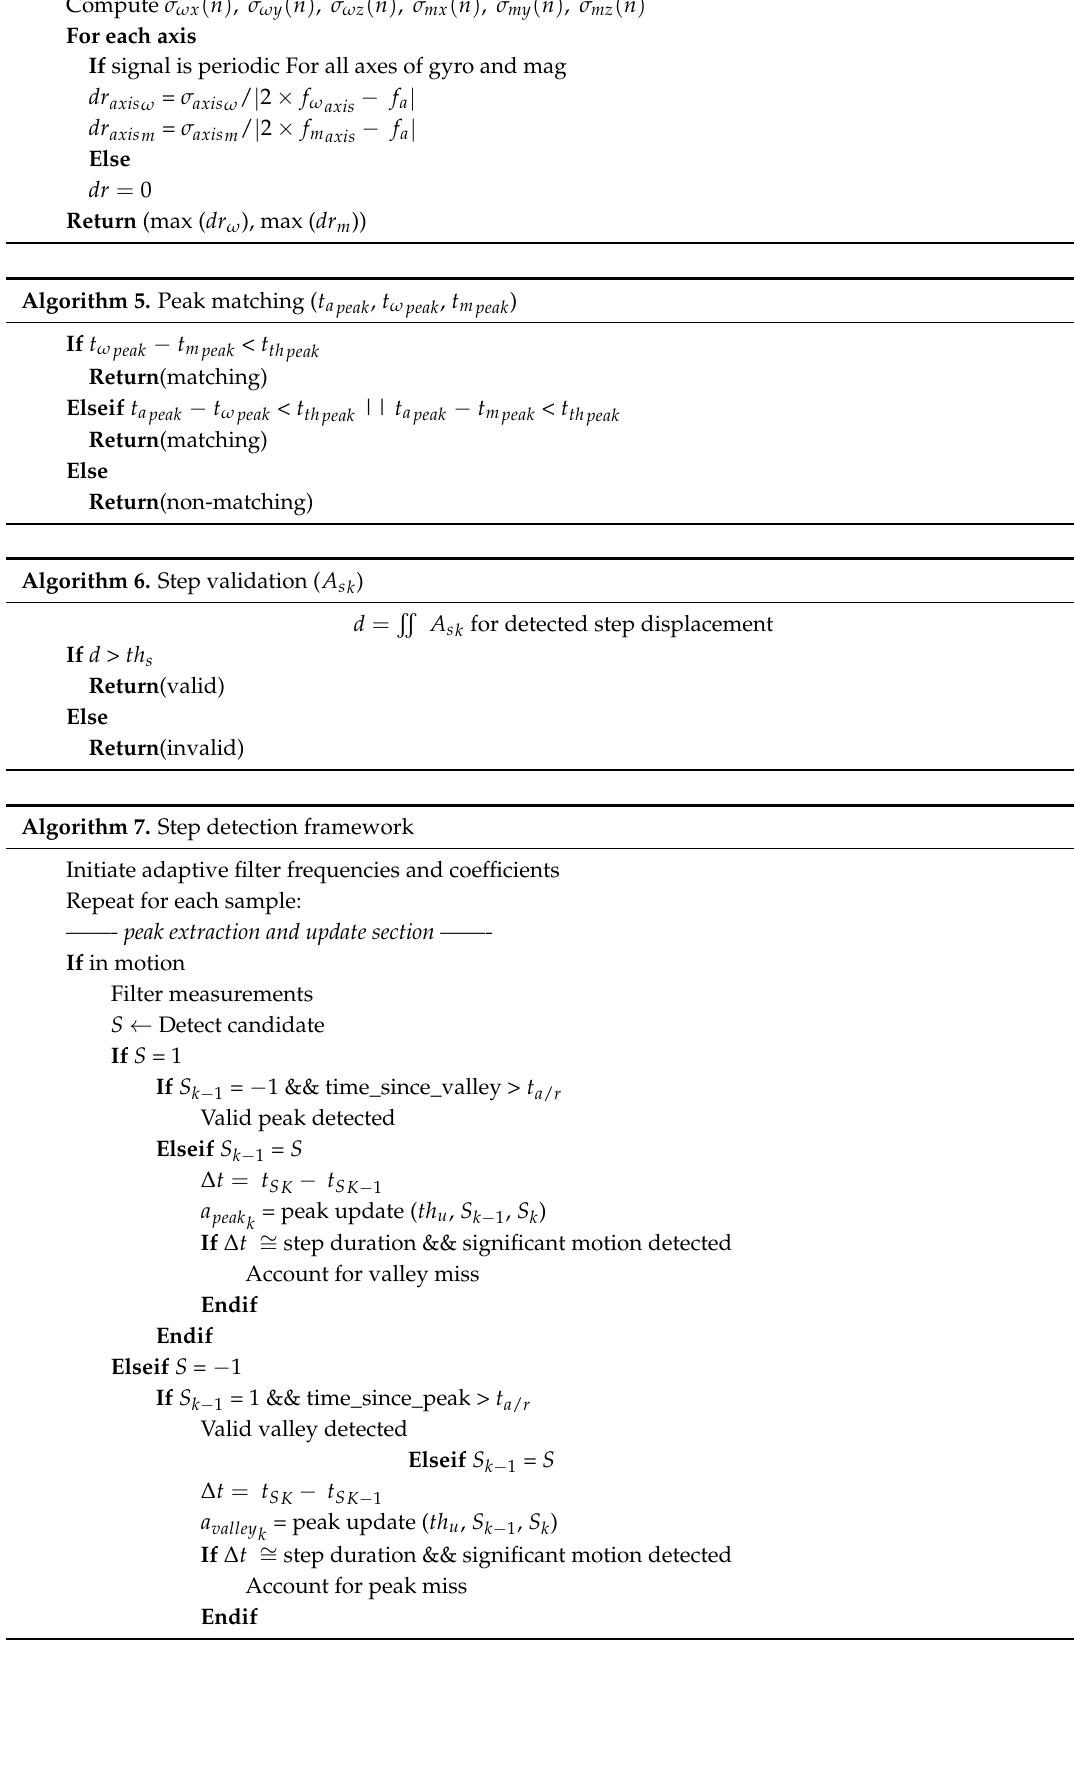
Algorithm 4. Dominant axis extraction( ω ( n ) , m ( n ))